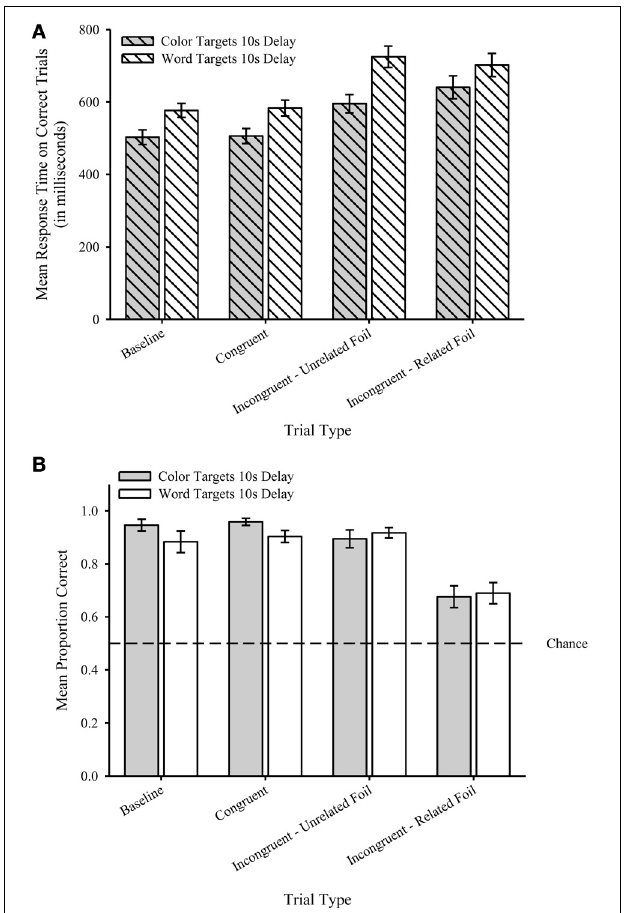
FIGURE 3 | (A) Mean response time during Testing (in milliseconds) plotted by Trial Type for Color Targets (filled bars) the Word Targets (unfilled bars) for Experiment 2. (B) Mean proportion correct during Testing plotted by Trial Type for Color Targets (filled bars) the Word Targets (unfilled bars) for Experiment 2. Dashed line represents chance performance (0.5). Error bars represent standard errors of the